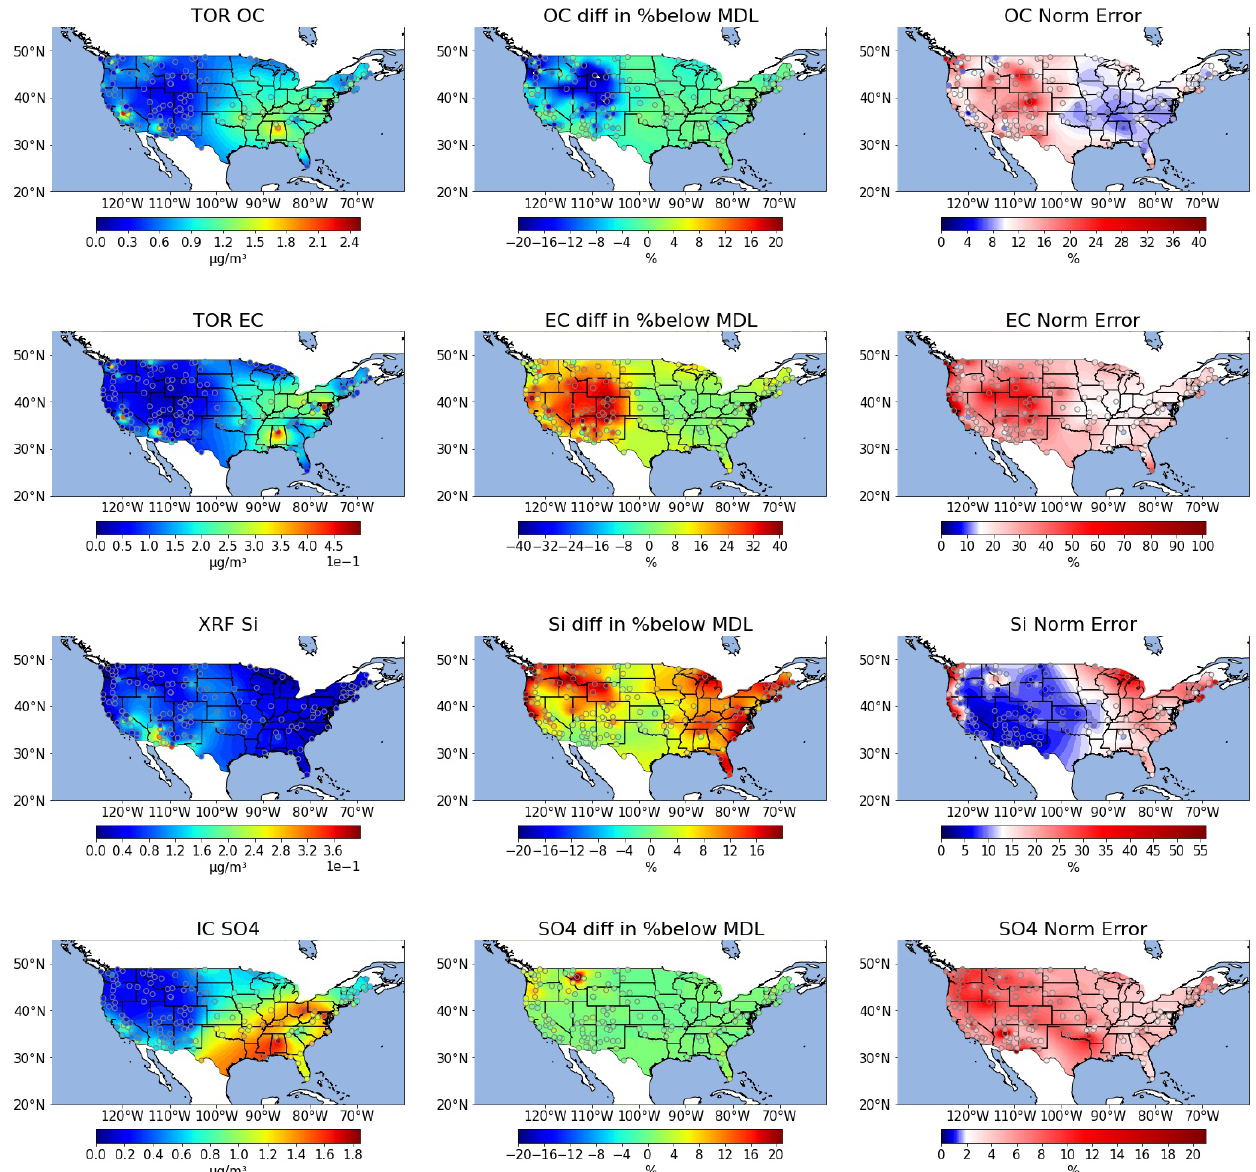
Figure 5. Annual median reference method concentrations (left), difference in % below MDL (middle) and normalized relative error (right) per site for OC, EC, silicon, and sulfate for CONUS for 2015. For the MDL plot, sites in green and blue indicate that the FTIR has the same or fewer samples below MDL than the reference method. Sites in yellow and red have more samples below MDL for FTIR than for the reference method. For the relative error maps, the median relative error of the reference method estimated using methods described in Table 1 is white. For sites in blue, FTIR has lower relative error than the reference method and sites in red are